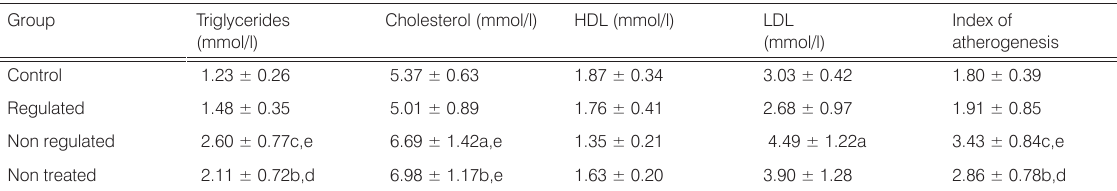
Table 2. Triglycerides, cholesterol, HDL, LDL and index of atherogenesis among investigated groups